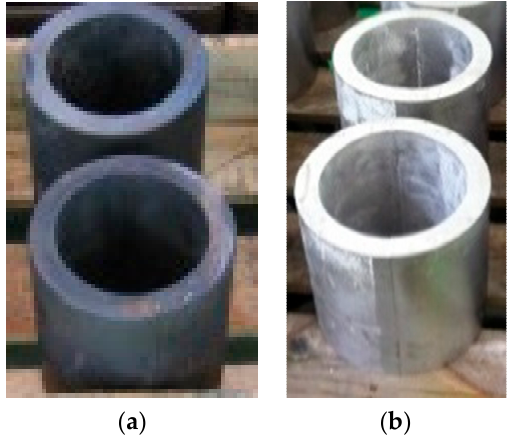
Figure 11. Surface cleanliness: ( a ) Water cooling; ( b ) nitrogen cooling.